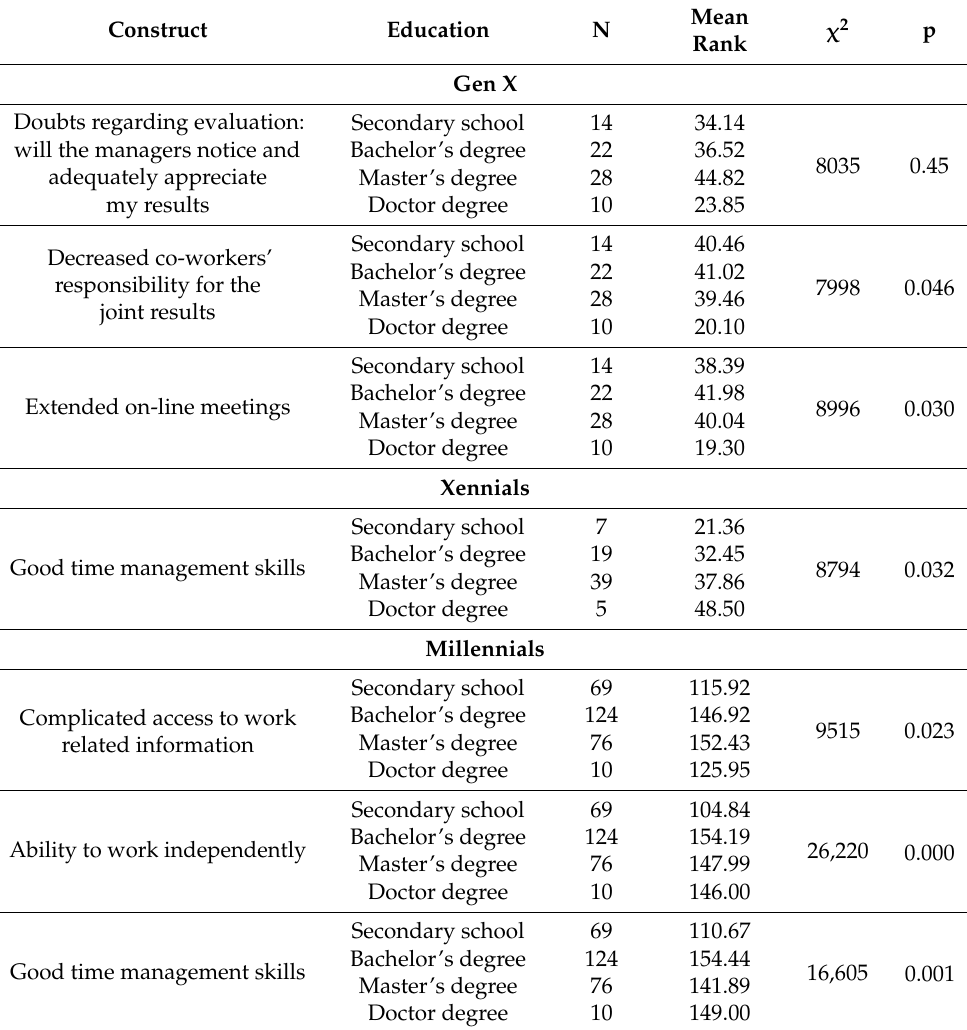
Table 9. The evaluation of teleworking among the different groups of